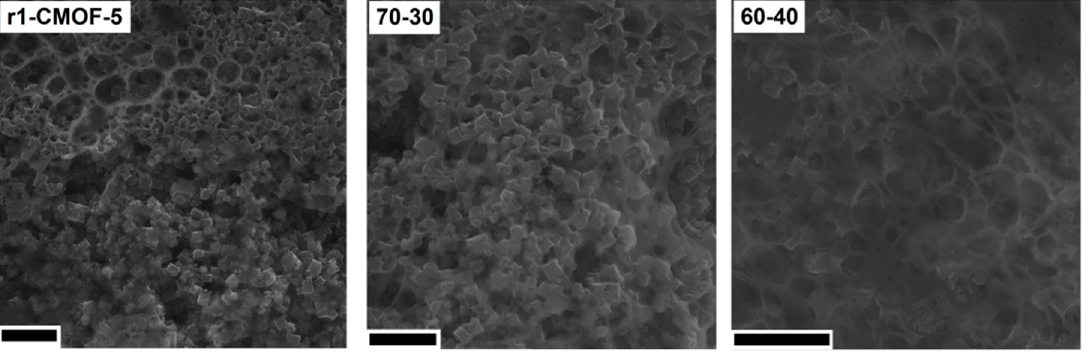
Figure 12. The SEM images of the electrodes from the recycled CMOF-5 and electrodes prepared with ratio 70:30 and 60:40 (scale bar 10 nm). ratio 70:30 and 60:40 (scale bar 10 nm).